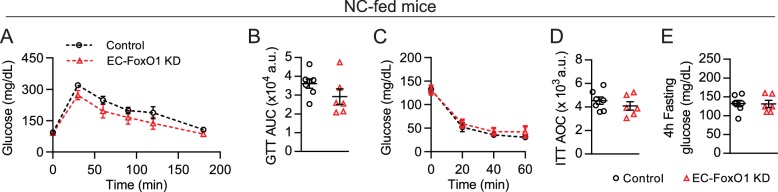
EC-Foxo1 depletion does not affect glucose homeostasis in NC-fed mice.Glucose metabolism was assessed in Control and EC-FoxO1 KD mice after 16 weeks of NC diet. (A) Glucose tolerance of Control and EC-FoxO1 KD mice was examined by intraperitoneal glucose tolerance test after 15 weeks of NC diet and 16 hr fasting (Control n = 7 and EC-FoxO1 KD n = 6). (B) Area under the curve (AUC). (C) Insulin sensitivity of Control and EC-FoxO1 KD mice was assessed by intraperitoneal insulin tolerance test after 14 weeks of NC diet and 4 hr fasting. (D) Area over the curve (AOC, Control n = 7 and EC-FoxO1 KD n = 6). (E) Plasma glucose levels after 4 hr fasting (Control n = 7 and EC-FoxO1 KD n = 6). Data in all panels are expressed as mean ± SEM.